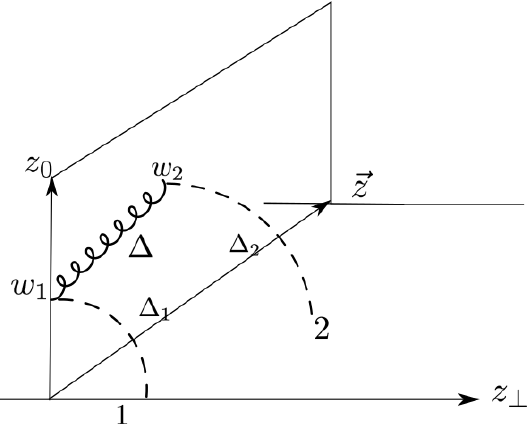
Figure 3 . The interface-channel geodesic Witten